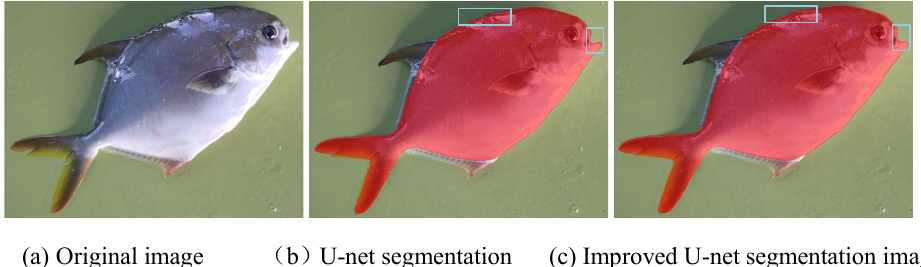
Fig. 11 Comparison of segmentation effects of two algorithms when the fish body is tilted.